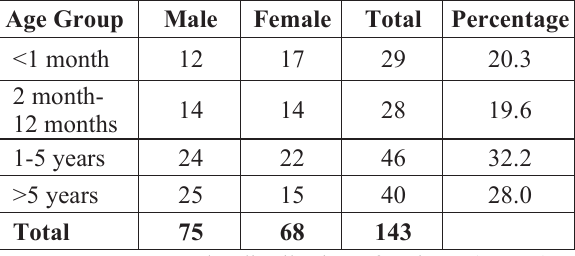
Table-1: Age & gender distribution of patients (n=143) Area involved